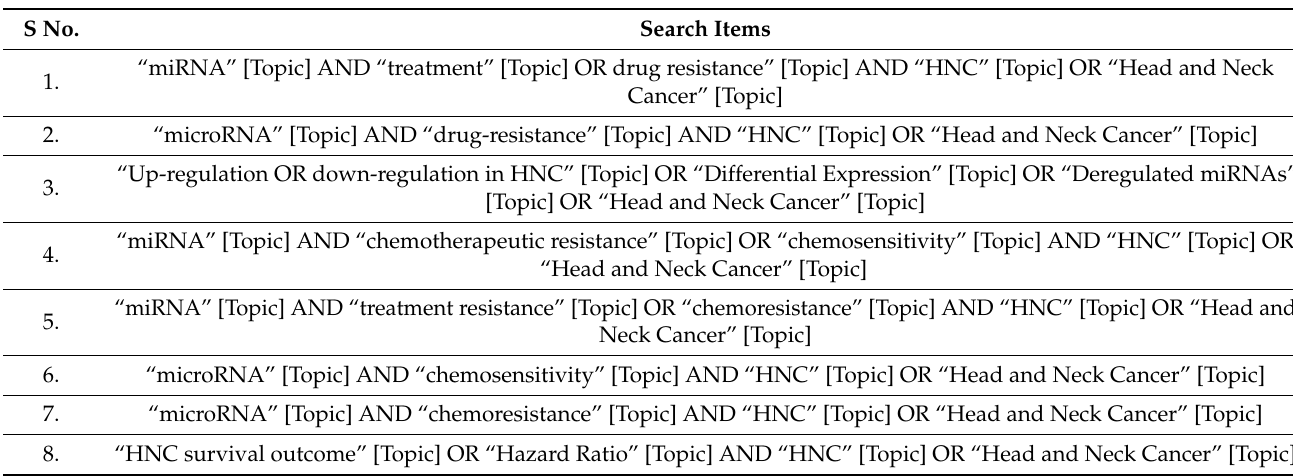
Table 1. Key terms utilized in the search